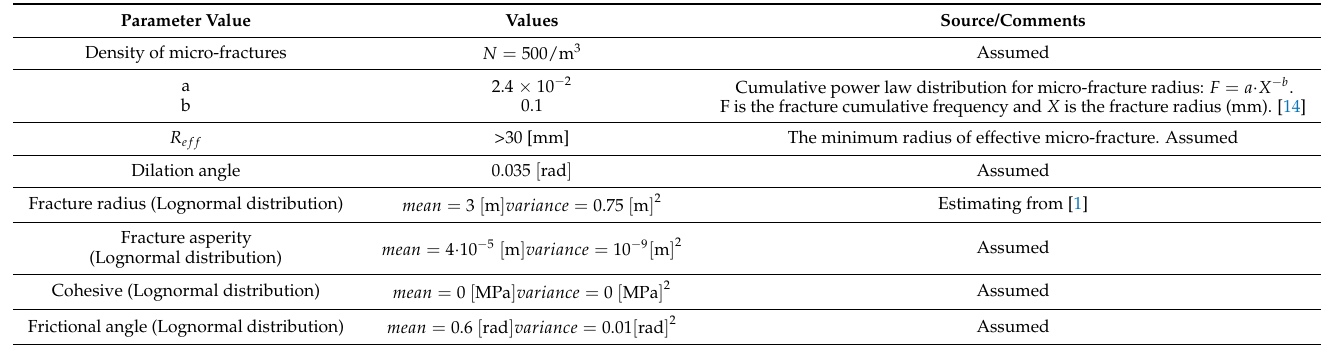
Figure 10. The configuration of major fractures and their orientation [2]. ( a ) There are 101 major fractures in this configuration. Most fractures are steeply dipping. ( b ) Some major fractures surround the Notch ≅ 164. An OT-PDT-P connection can be extracted from Figure 15b: E1-OT → OT-161 → PDT-114 → E1-PDT → P-122/126 → E1-P or E1-OT → OT-161 → P-126/127 → E1-P. Such a connection partly matches the field observation during the fracture mapping exercise [58]. Table 2. Fracture network properties used in the